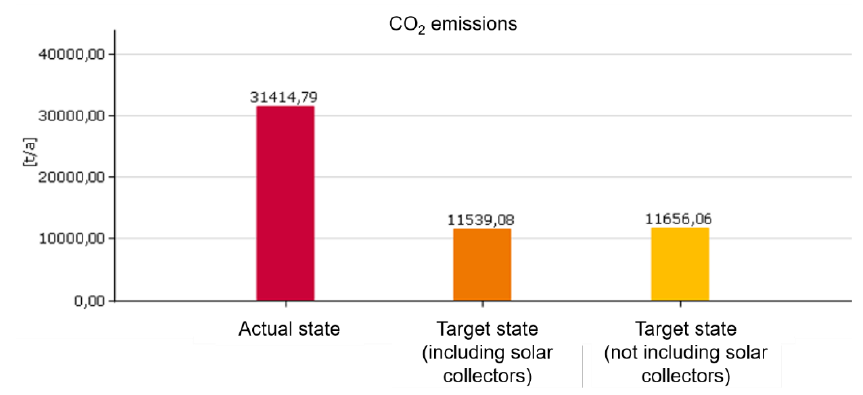
Figure 9. Comparison of CO